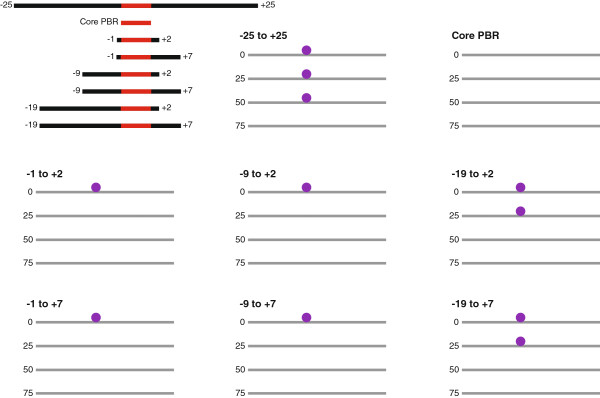
High stringency HB binding site predictions in the IAB7b CRM. PWMs corresponding to the 7 bp core predicted binding region (PBR, red) or the core PBR with flanking sequences of various sizes (black) were used to predict HB binding sites in the 828 bp IAB7b enhancer with an initial cutoff threshold ln(p-value) = -7.53 (corresponding to the 50th percentile). For each individual PWM, a secondary cutoff at the 0th, 25th, 50th or 75th percentile of all the ranked sites (see Methods for details) was also applied. Note that at this primary cutoff score the core PBR fails to predict the true positive HB binding site (purple circle) and as the length of the PWM is increased more robust predictions are made.